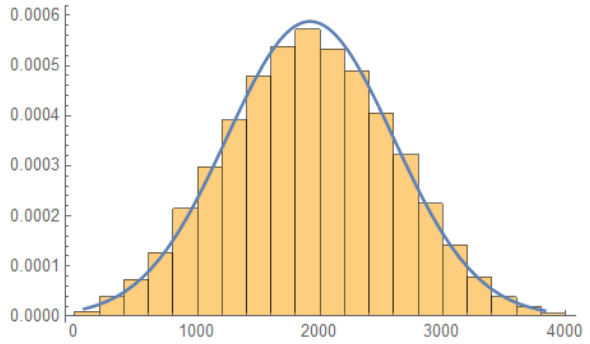
Figure 4. Histograms where a three rotations model has been applied over an LFSR generated controlled by a primitive polynomial of degree m =